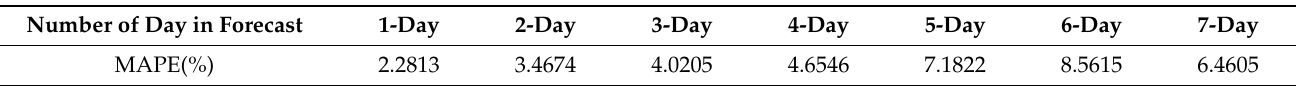
Figure 2. Correlation coefficient between the seven ‐ day moving average of ED visits with fever and daily patients of influenza in the NHIS.